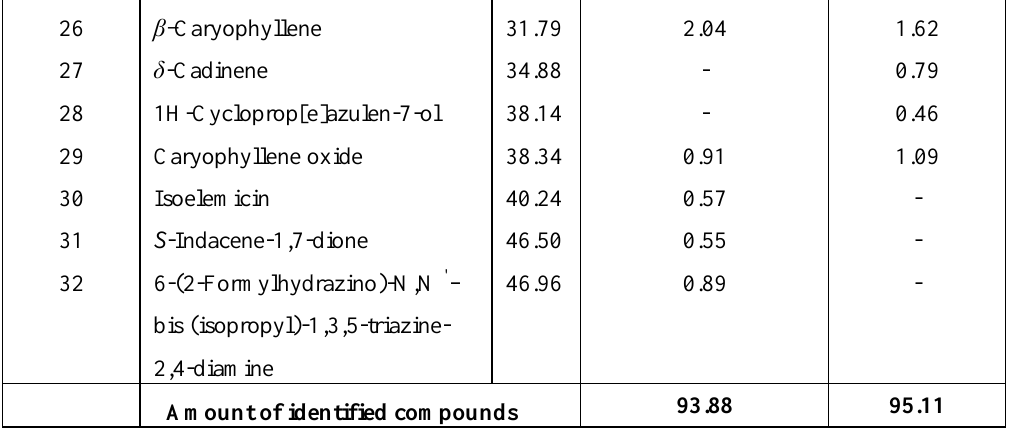
Figure 1. p -Cymene and carvacrol and their total relative amounts in the two essential oils (%).